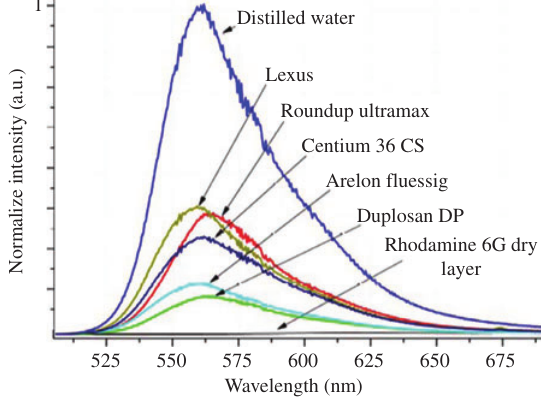
Fluorescence emission spectra of pesticide micro drop- lets applied on rhodamine 6G layer on an ivy leaf; the spectra were obtained using a LIF system (excitation at 337 nm) ( Hake et al. 2007 ).